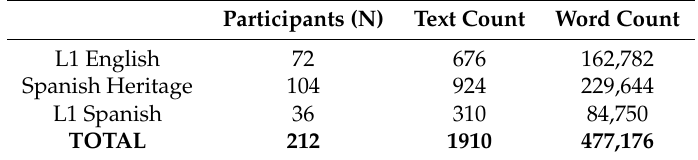
Table 3. Distribution of participants, texts, and total word count across the three L1 background groups.